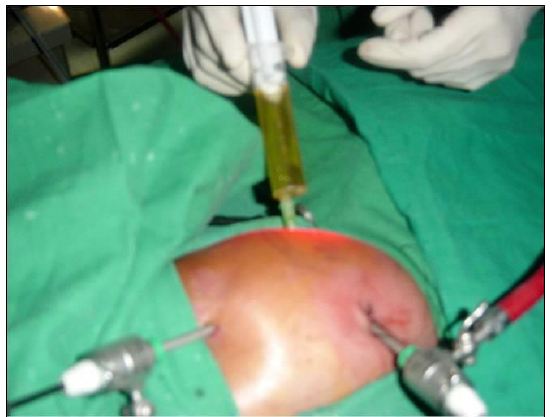
Figure 1: Ovarian cyst aspiration under laparoscopic guidance